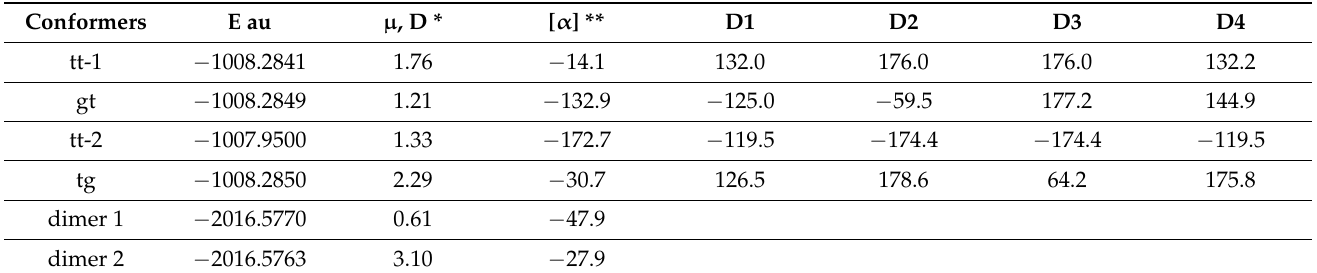
Table 1. Results of quantum-chemical calculations of CPDA conformers and dimers.